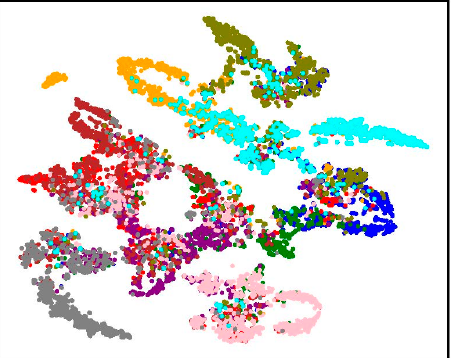
Figure 2. t-SNE visualization of the feature distribution of the adversarial examples of an 11-layer CNN trained by AT. Examples of the same color have the same ground-truth label.